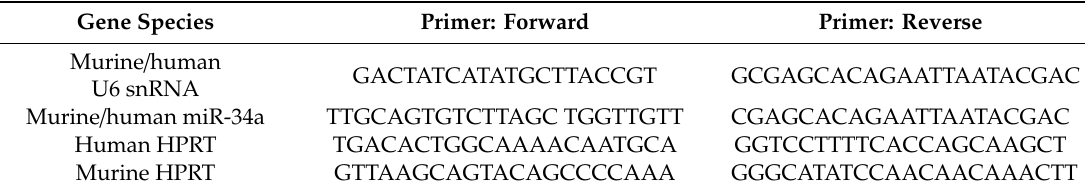
Table 1. Primers for